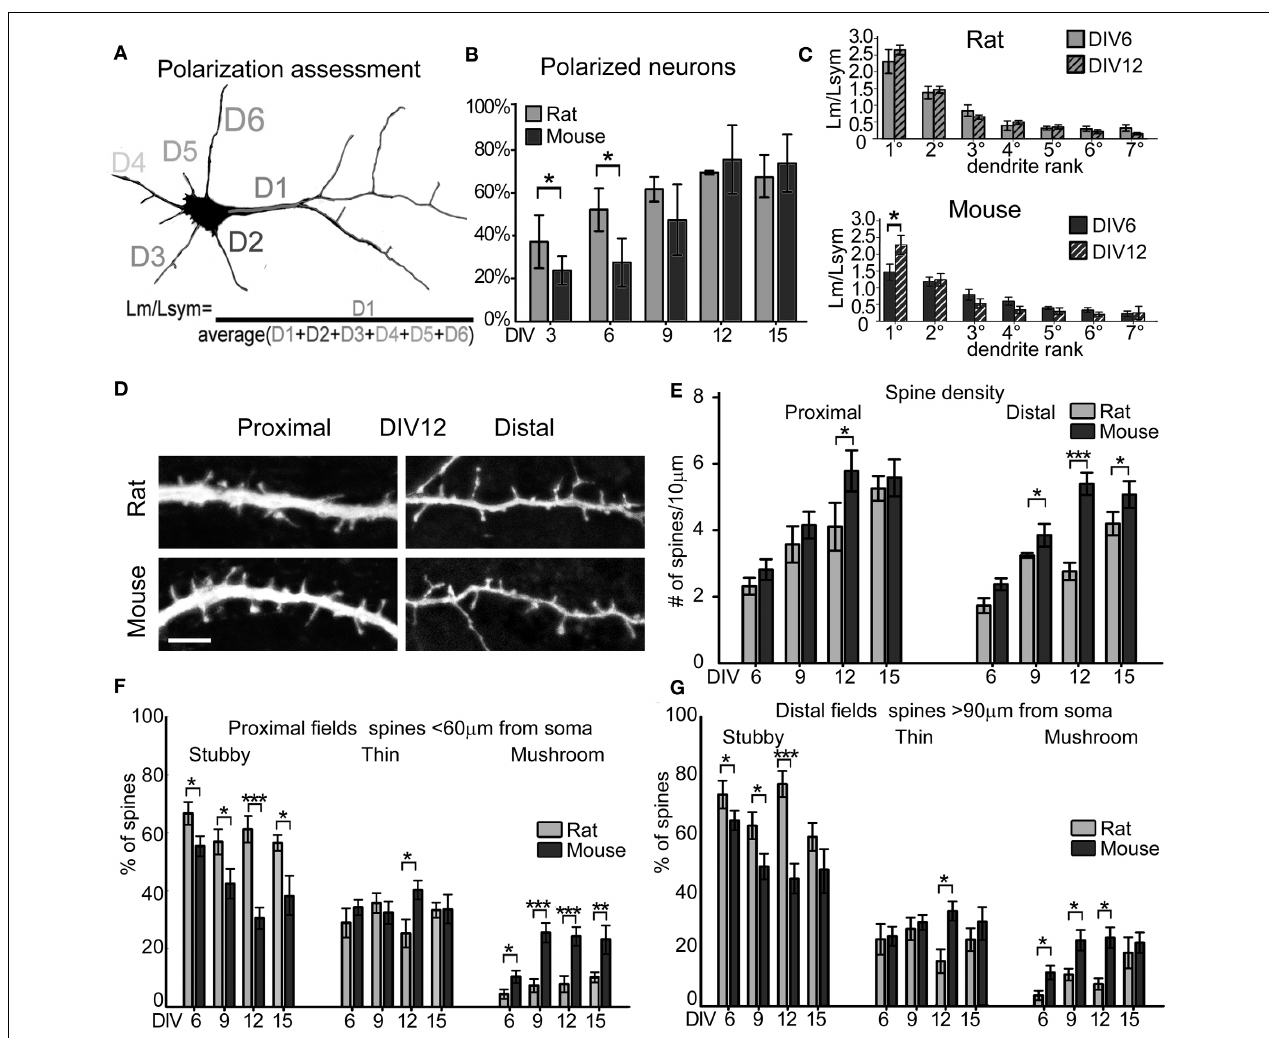
length (Lm) to the Lsym. Dendrites are ranked longest to shortest ( N = 50 neurons; 3–4 cultures). (D) Proximal and distal 40 µ m-long fields of mouse and rat apical dendrites. (Scale Bar = 5 µ m). (E) Spine density in apical dendrite proximal and distal region of mouse (dark gray) and rat (light gray) at DIV6, 9, 12, 15. (F,G) Spine type percentage (mean, standard errors). ∗∗∗ p ≤ 0 . 001, ∗∗ p ≤ 0 . 01, ∗ p ≤ 0 . 05 (One-Way ANOVA with Holm-Sidak’s pairwise multiple comparison).